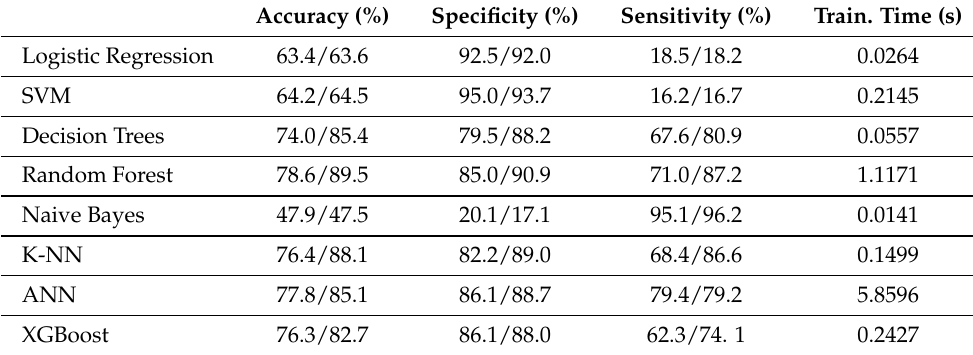
Table 3. The performance comparison of different classifiers with general and R-peak-based folding of ECG segments. Except for training times, the larger values are